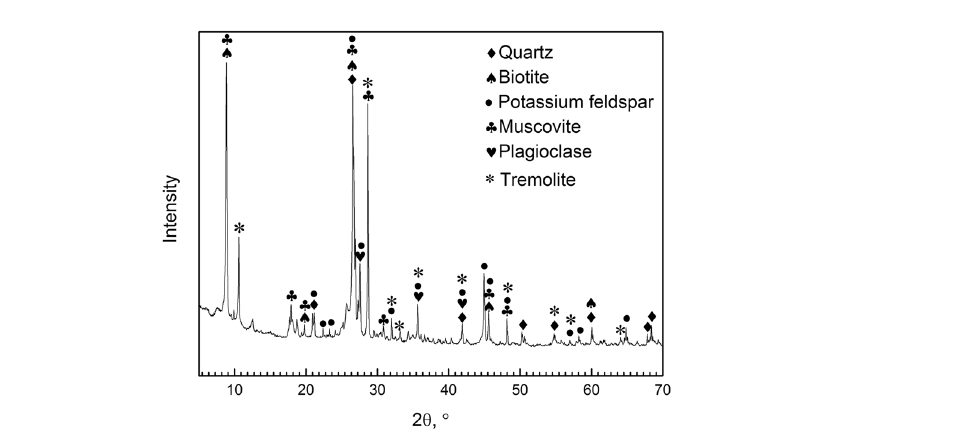
Figure 8. XRD pattern of the copper